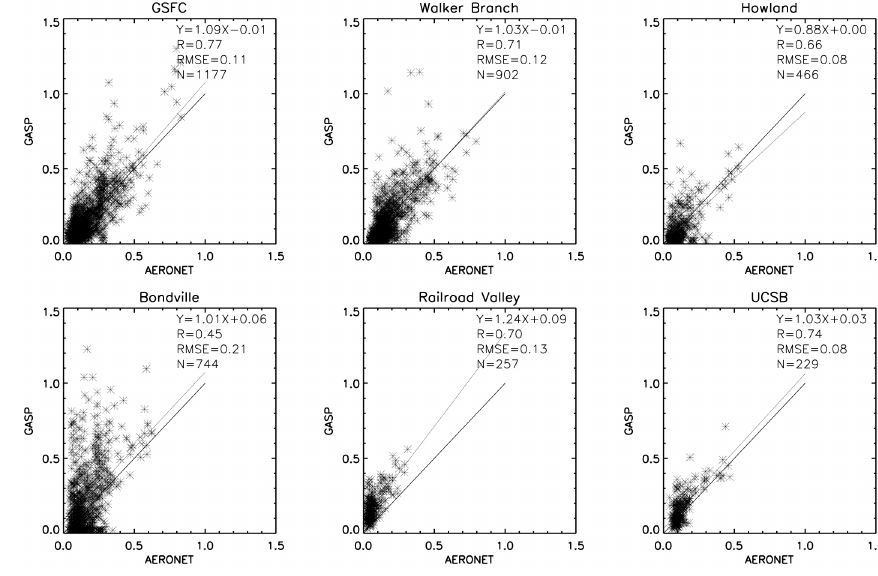
Fig. 6. Scatter plot of GASP vs. AERONET AOD.